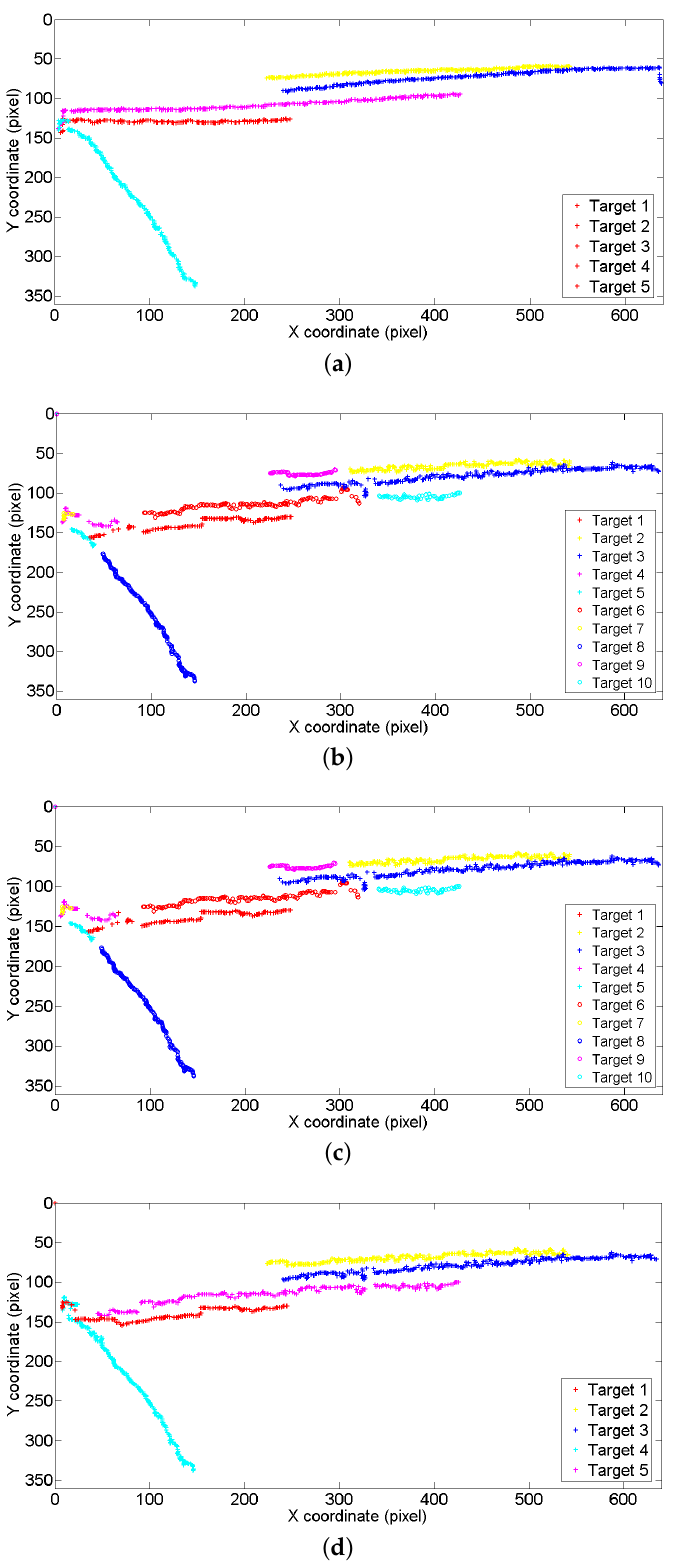
Figure 10. Tracking trajectories on an outdoor human surveillance scenario. ( a ) Ground truth; ( b ) for the GM-PHD tracker; ( c ) for the CPGM-PHD tracker; ( d ) for our